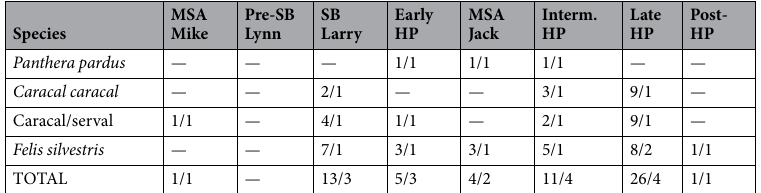
Felis silvestris